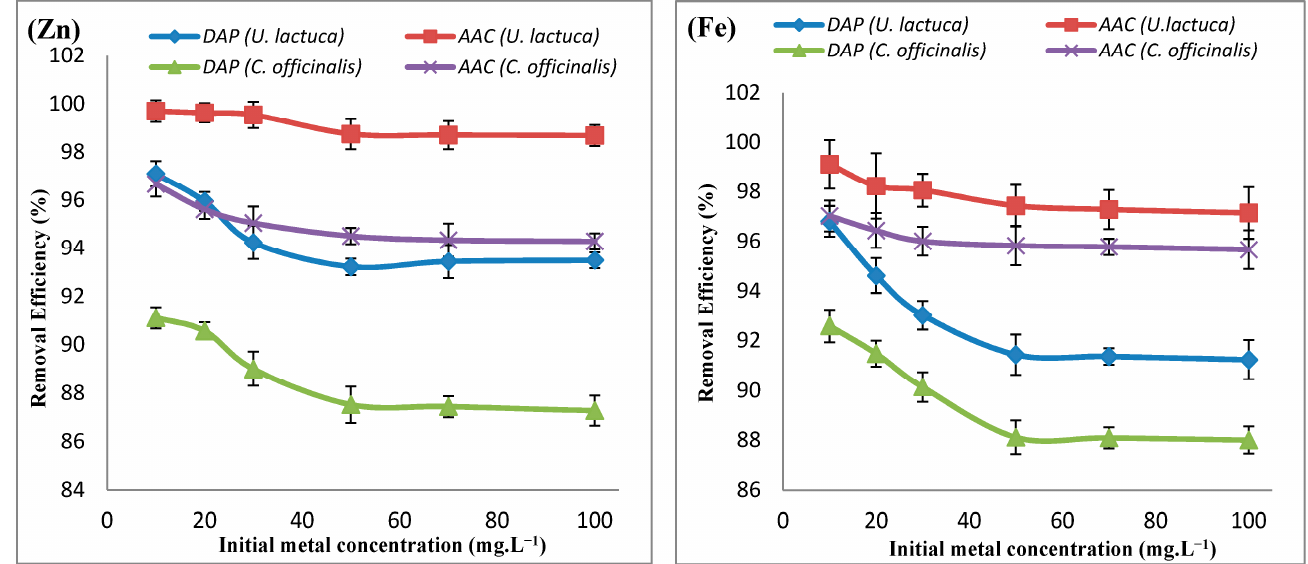
Figure 4. Effect of initial concentration of metal ion (mg.L − 1 ) on the percentage of removal of Zn +2 and Fe +3 (at 120 min., pH 5.0 and 1.0 g.L − 1 ) using dried algal powder (DAP) and the activated carbon (AAC) of both U. lactuca and C. officinalis . Each data point represents the mean ± SD.